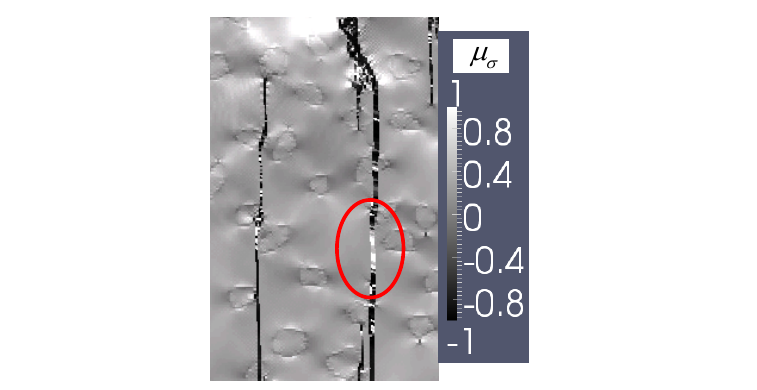
Figure 4: The part of specimen area reflecting the kind of the stressed state in the composite defined by the Lode-Nadai parameter  